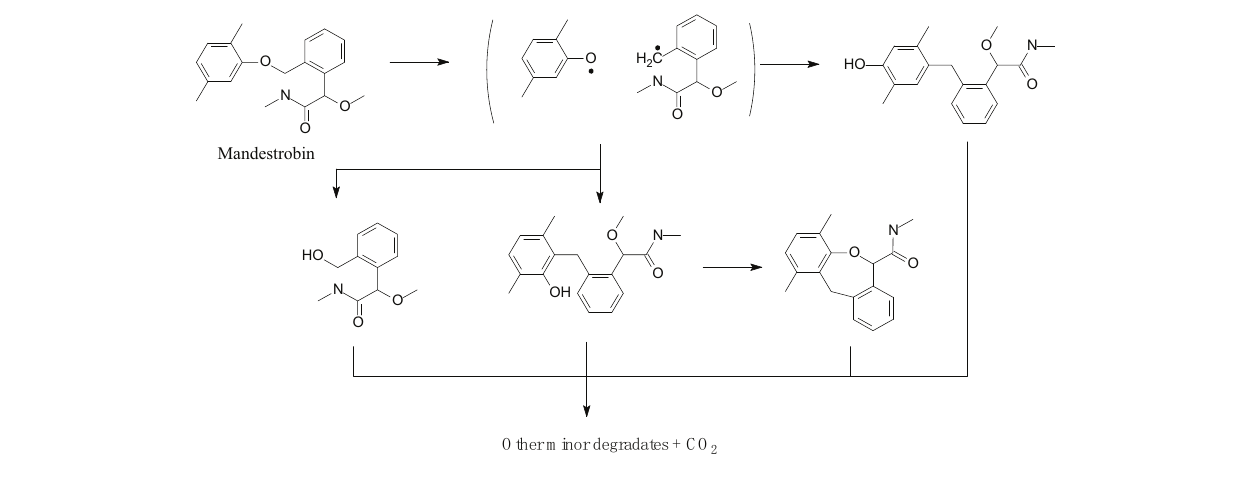
FIGURE 6 | Proposed degradation pathway of mandestrobin (based on Adachi et al.,